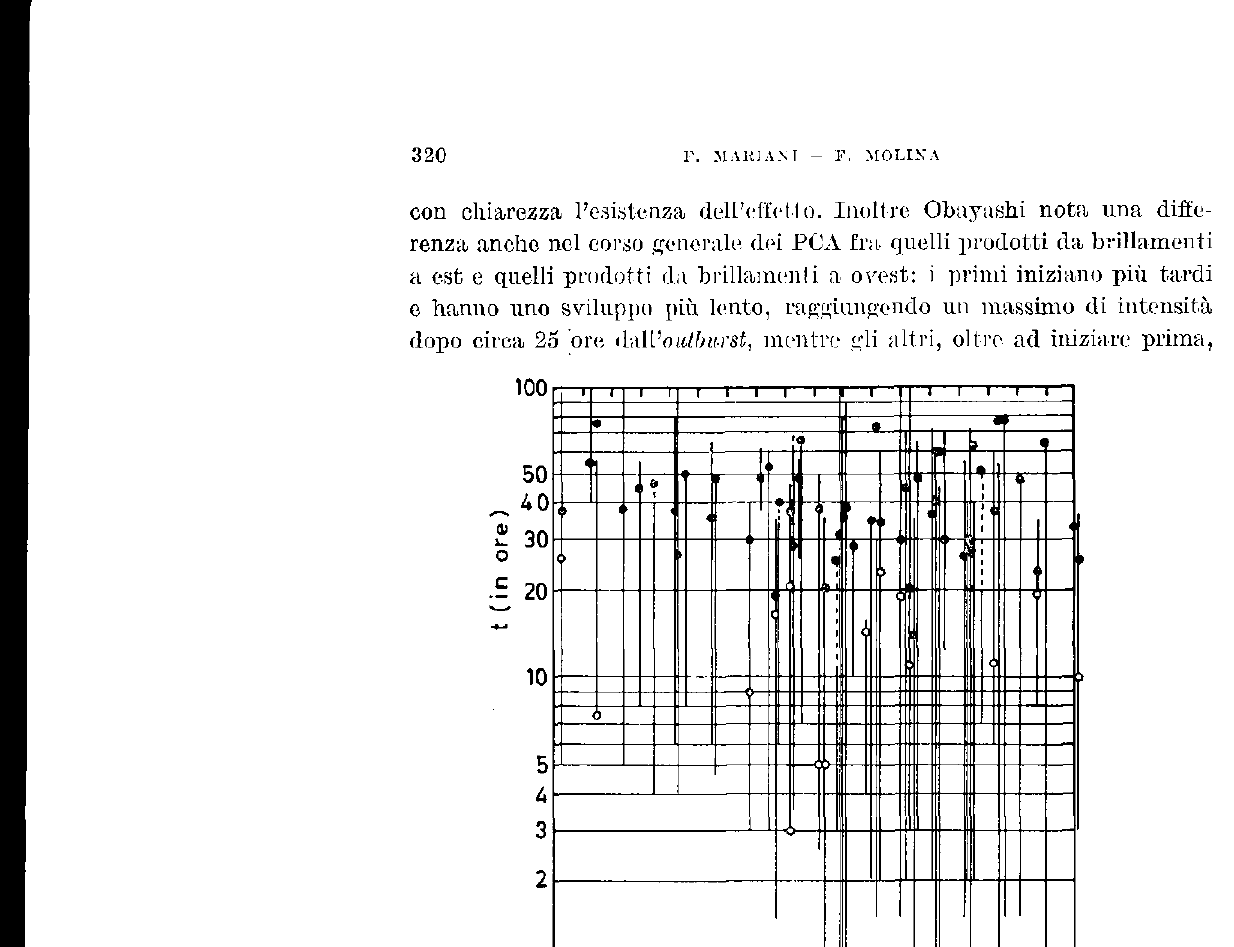
Fig. 5.44 - Dipendenza del tempo di ritardo t dopo l 'outburst dalla lon- gitudine eliografica A. Le linee continue rappresentano i PCA; i circoletti neri sono s.s.c. di tempeste magnetiche di tipo singolo, i circoletti chiari sono s.s.c. di tempeste di tipo complesso, (secondo